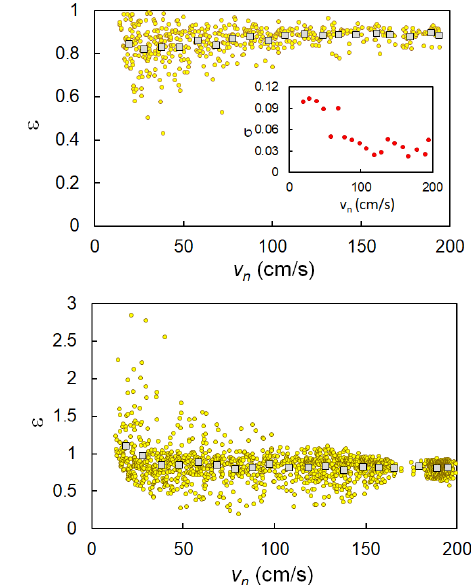
Fig. 2. Coefficient of restitution as a function of V n , the normal (vertical) impact velocity for a particle colliding with a flat surface. Square markers are mean values of  sampled in windows of width 10cm/s for V n , plotted vs. < V n > obtained in the mentioned windows. Inset: shows standard deviation for values of  sampled in windows of width 10cm/s for V n . Top panel: disk. Bottom panel: faceted particle.